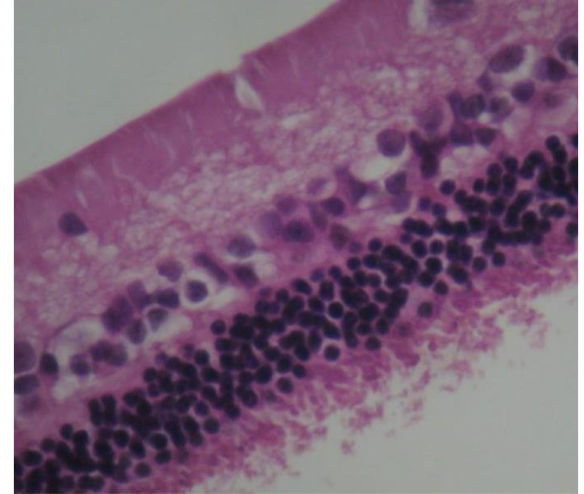
Figure 6. Group V. No pathological changes were observed in the retina. EH. × 240.